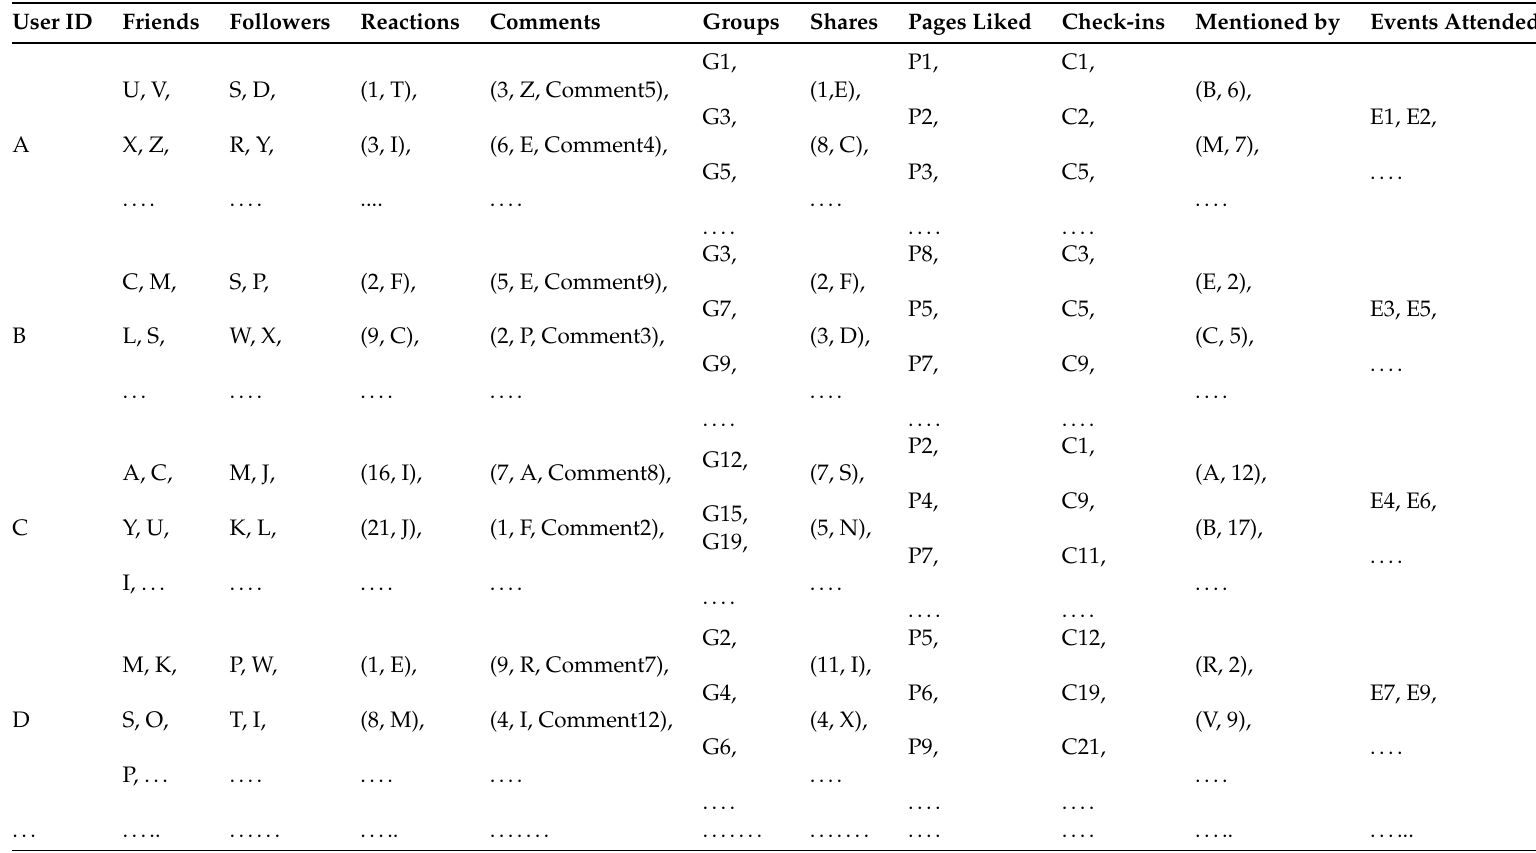
Table 1. Facebook